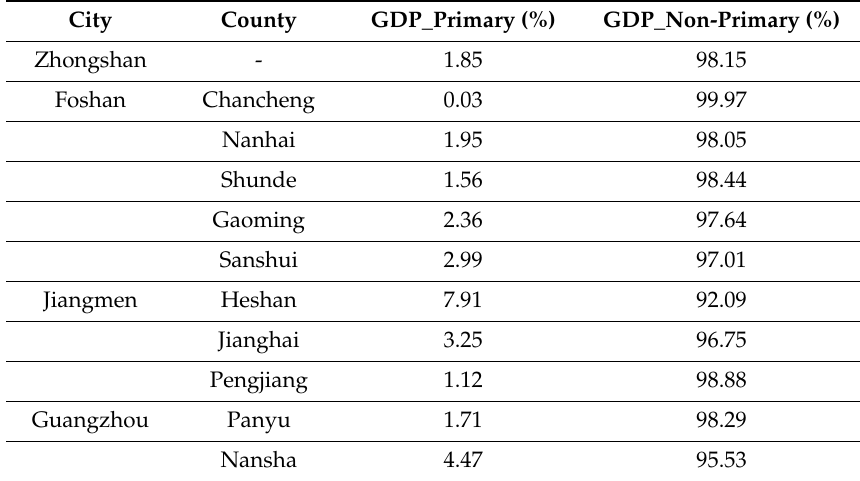
Table 2. Primary and non-primary Gross Domestic Product (GDP) contribution ratios at county- and city-levels averaged over years 2015–2017 for the study